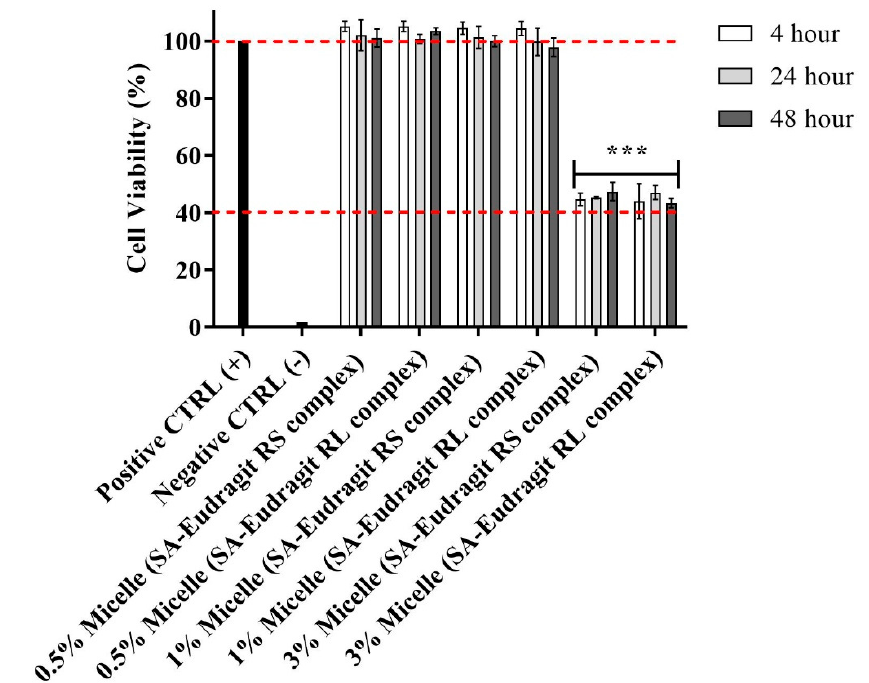
Figure 3. Effects on Caco-2 cell viability of 0.5:100, 1:100, and 3:100 dilutions of micellar pre-concentrates containing SA-polymer complexes with Eudragit RS and Eudragit RL in 25 mM HBS (pH 7.4) after 4, 24, and 48 h incubation at 37 ◦ C. A 3:100 versus 1:100 and 0.5:100 micellar dilutions indicated significant decreases in cell viability ( *** p ≤ 0.001). Indicated values are the means ± SD ( n ≥ 3).